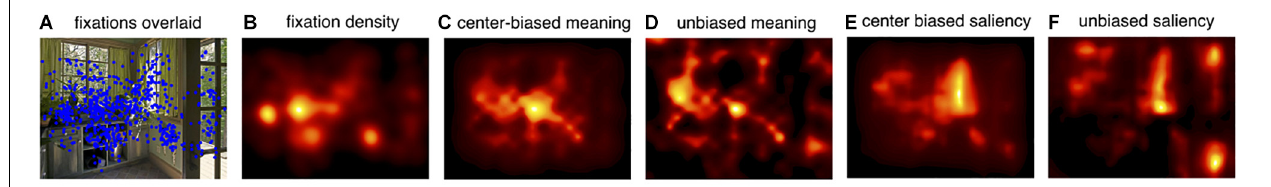
FIGURE 3 | Map examples. (A) Shows the example scenes with fixations overlaid and (B) is the fixation density map for the example scene. (C) Shows the center-biased meaning map and (D) shows the unbiased meaning map for the example scene. (E) Shows the center-biased saliency map and (F) shows the unbiased saliency map for the example